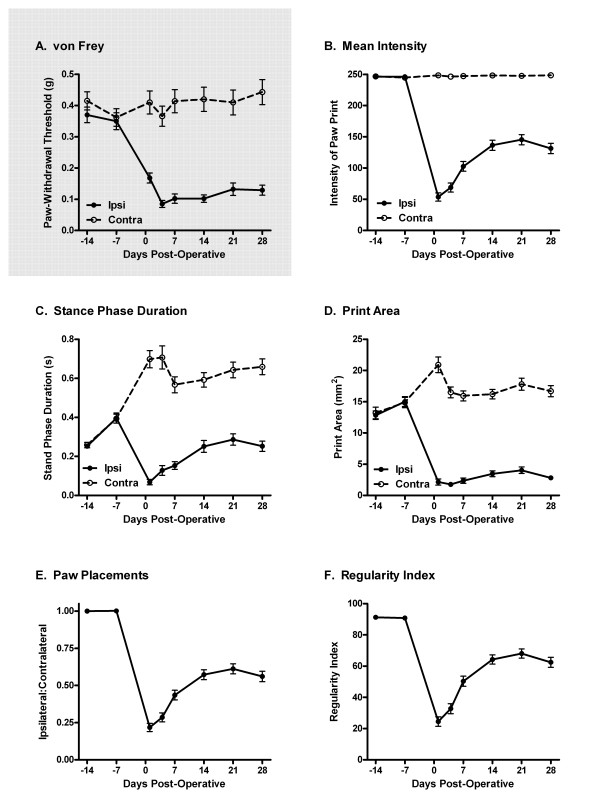
Dissociation of time course of mechanical allodynia and dynamic weight bearing (gait) changes following SNI injury. Data are combined from 22 inbred mouse strains (see text). Symbols represent mean ± S.E.M. 50% withdrawal threshold from von Frey filaments (g; in A), and mean ± S.E.M. CatWalk gait parameters including: (B) mean paw print intensity (arbitrary scale from 0-250), (C) stance phase duration (s), (D) paw print area (mm2), (E) paw placement ratio (ipsilateral: contralateral), and (F) regularity index (arbitrary scale from 0-100). For definitions see main text. In all graphs, data from the ipsilateral hindpaw is shown using closed symbols and solid lines; where relevant, data from the contralateral hindpaw is shown using open symbols and dashed lines. No significant changes in forepaw parameters were seen (data not shown). Note that mechanical allodynia peaks at post-operative day 4 and remains statistically unchanged thereafter, whereas CatWalk gait parameters display maximal changes at post operative day 1 and then partially recover. Individual significance levels are not shown for clarity; owing to the very large sample size (n = 122) all statements above are supported at p < 0.001 by repeated measures ANOVA.